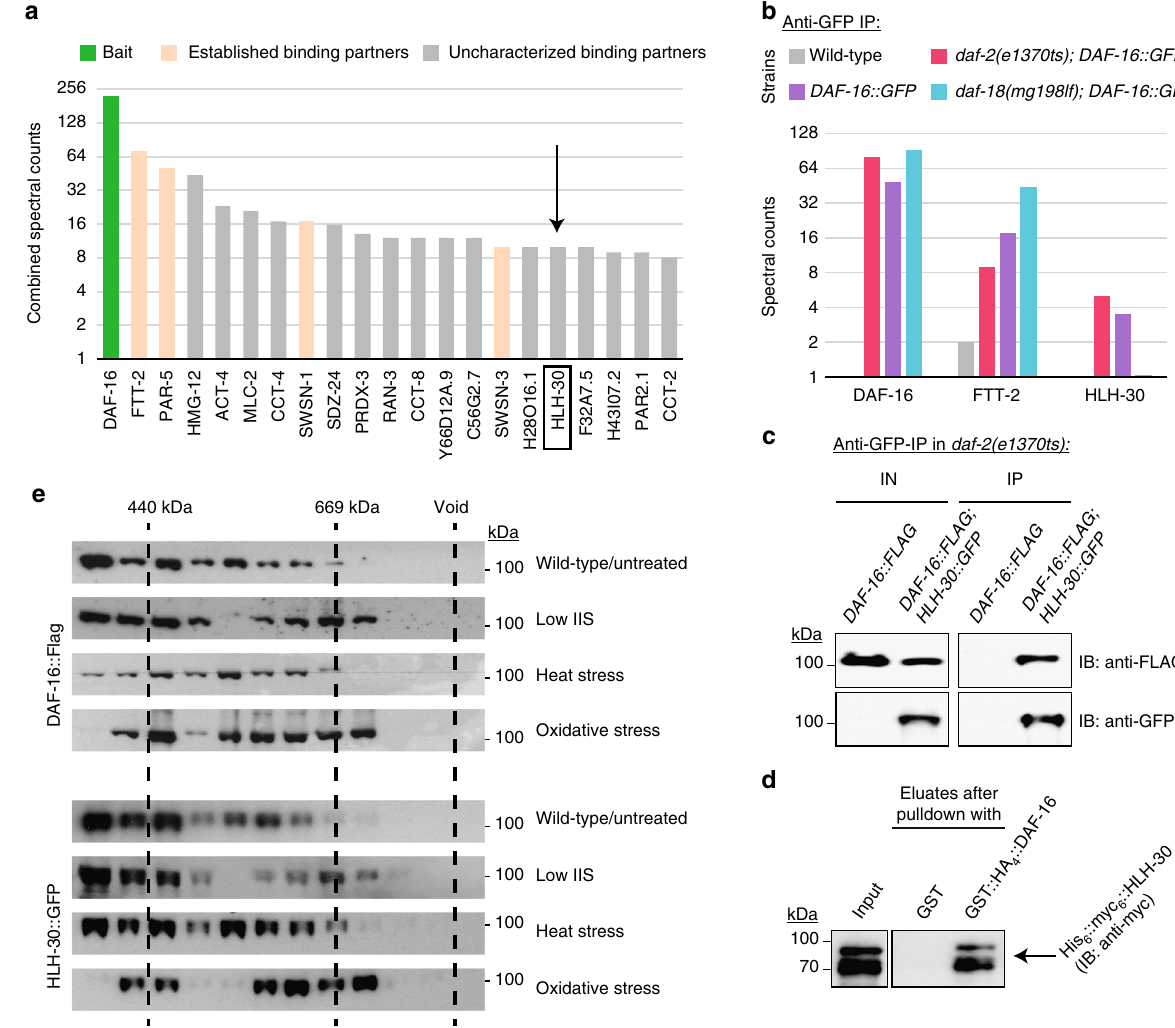
Fig. 1 DAF-16/FOXO binds to the transcription factor HLH-30/TFEB. a , b DAF-16 binds to HLH-30, preferentially when it is activated by low IIS. Large-scale anti-GFP immunoprecipitations from whole-worm lysates of animals expressing DAF-16::GFP in either a wild type, daf-2(e1370ts) , or daf-18(mg198lf) background. Immunoprecipitated material was analyzed by mass spectrometry (LC-MS/MS). In a , spectral counts from all three puri fi cations were combined and the 21 most abundant proteins are shown, including the bait DAF-16 and several of its established binding partners. The arrow indicates the most abundant co-purifying transcription factor, HLH-30. In b , the spectral counts for each puri fi cation were kept separate and are shown for the bait, the 14-3-3 protein FTT-2, as well as HLH-30. c Con fi rmatory co-immunoprecipitation (co-IP). HLH-30::GFP was immunoprecipitated from whole-worm lysates of the indicated C. elegans strains using GFP-Trap resin. Benzonase (50 U ml − 1 ) was added to eliminate DNA- or RNA-mediated interactions. Inputs (IN) and eluates (IP) of the co-IP were analyzed by SDS-PAGE and western blotting. For the inputs (IN), only fractions were loaded: 5% for the anti-FLAG western blot and 50% for the anti-GFP western blot. IB: antibody used for immunoblot. d In vitro binding assay. Recombinantly expressed His 6 ::myc 6 ::HLH- 30 was pulled down using Glutathione-Sepharose resin coated either with recombinant GST or GST::HA 4 ::DAF-16. Samples were analyzed by SDS-PAGE and western blotting. For the input, only 50% of the sample were loaded. e Size-exclusion chromatography, illustrating the size distributions and thus complex incorporation of DAF-16 and HLH-30 under different conditions. C. elegans co-expressing DAF-16::FLAG and HLH-30::GFP were treated in the indicated ways, either by use of daf-2(e1370ts) or by exposure for 6 h to either 32 °C or 6 mM t-BOOH. Animals were then immediately frozen, lysed, and their lysates subjected to size-exclusion chromatography on a Superose 6 column. Elution fractions were analyzed by SDS-PAGE and western blotting. Only higher molecular weight fractions are shown. For a full weight-spectrum of untreated animals see Supplementary Fig.